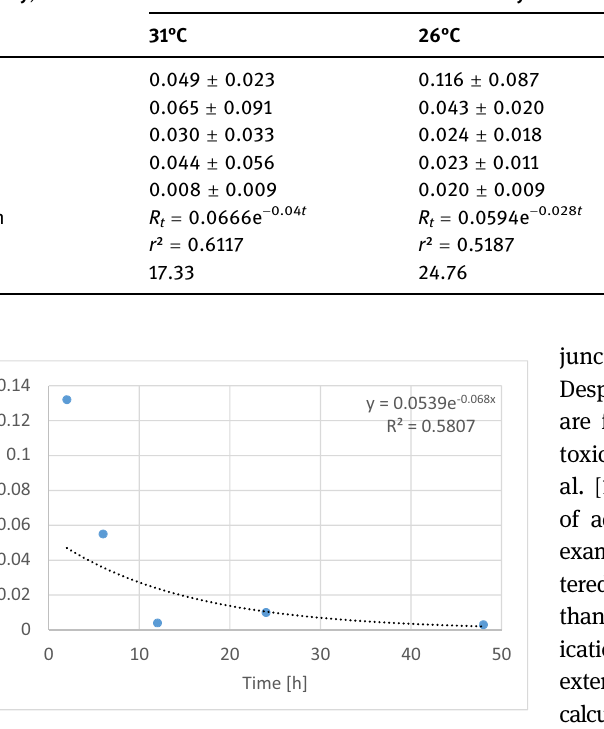
Figure 1: Exponential degradation trend of λ - cyhalothrin residues in bees incubated at 16°C ( n = 3 )